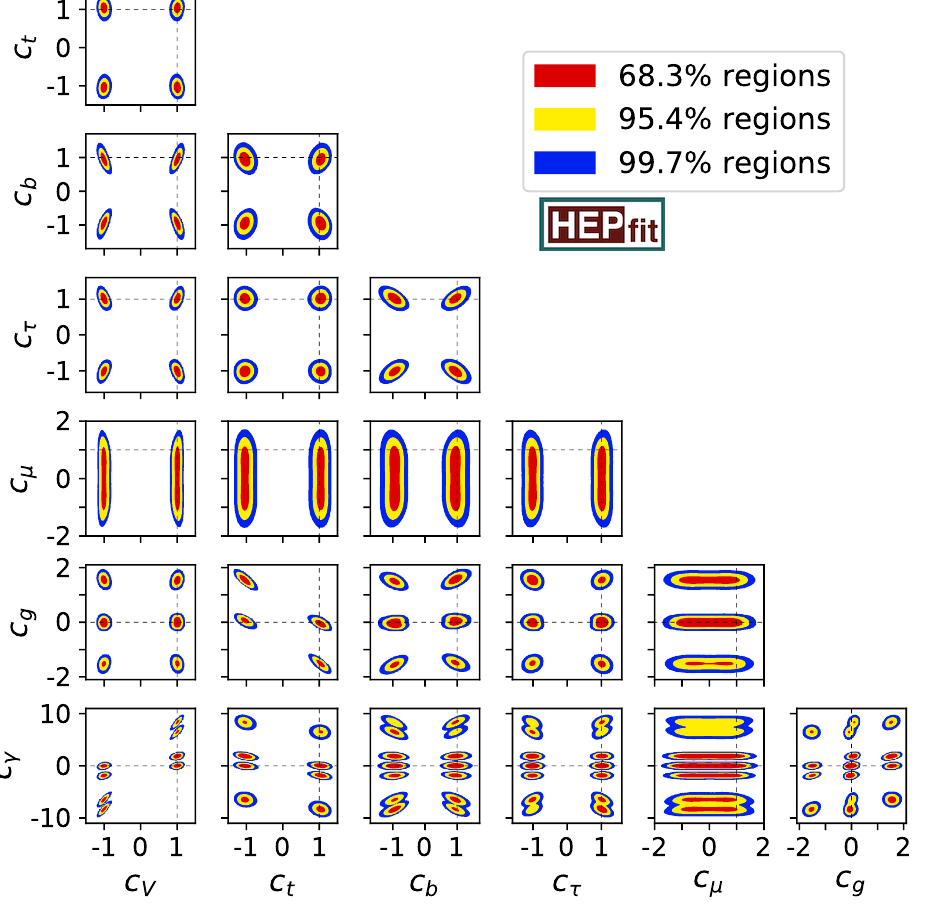
Figure 3 . We show the 68.3%, 95.4% and 99.7% probability regions in the c i vs. c j planes for i; j = V; t; b; (cid:28); (cid:22); g; (cid:13) . We do not assume that the c i are close to the SM values, which are represented by the dashed black lines, but we use wide (cid:13)at priors in order to (cid:12)nd all possible regions compatible with the current h signal strength bounds. Only for the experimentally poorly constrained c c and c Z(cid:13) we impose Gaussian priors with standard deviation (cid:27) = 0 : 5. These choices correspond to the set of priors P 0 described in eq. (4.3). See the text for